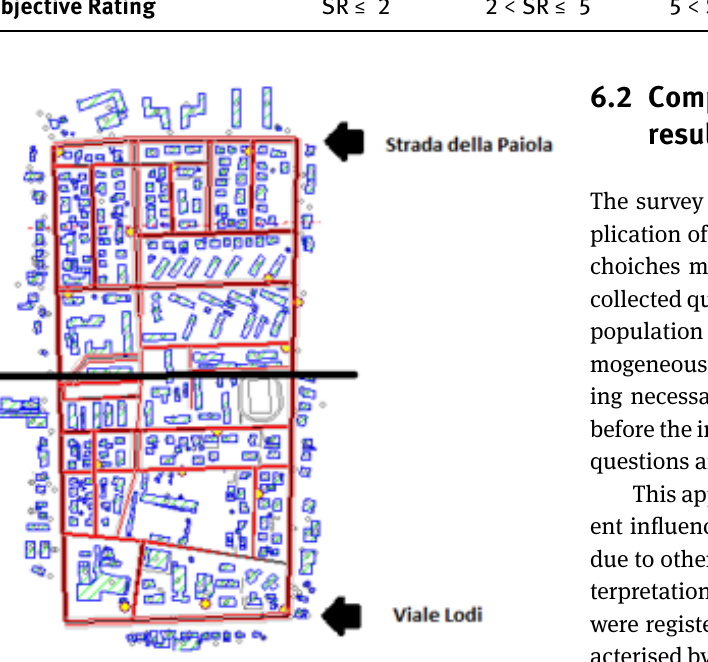
The question is focused on the feeling about the noise associated to different sources such as scoot- ers, motorcycles, vehicles, buses, trucks, trains, ur- ban activities, and warning